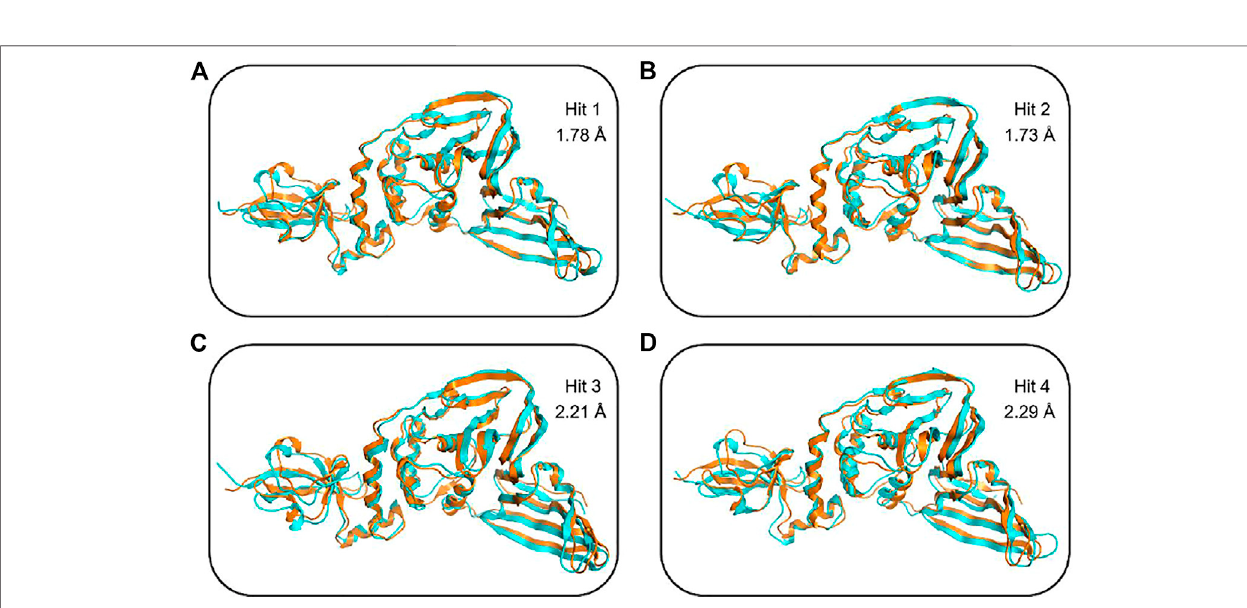
FIGURE7| Structuralsuperimposition ofthetop rankedclusterrepresentative ofPLpro-hitcomplexes(shownincyan)obtainedfromMD simulation ascompared to the PLpro alone (orange) without any ligand. (A) Secondary structure changes of PLpro protein upon binding to hit 1. (B) Secondary structure changes of PLpro proteinuponbindingtohit2. (C) SecondarystructurechangesofPLproproteinuponbindingtohit3. (D) SecondarystructurechangesofPLproproteinuponbindingto hit 4.